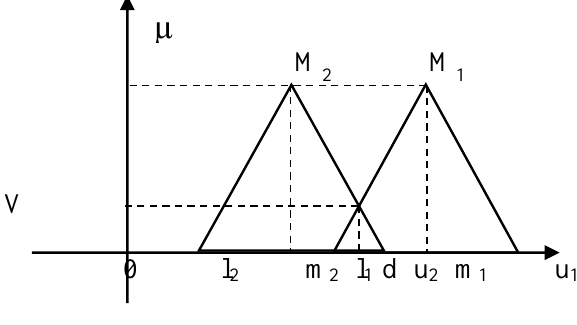
Figure 3 . The interaction between M1 and